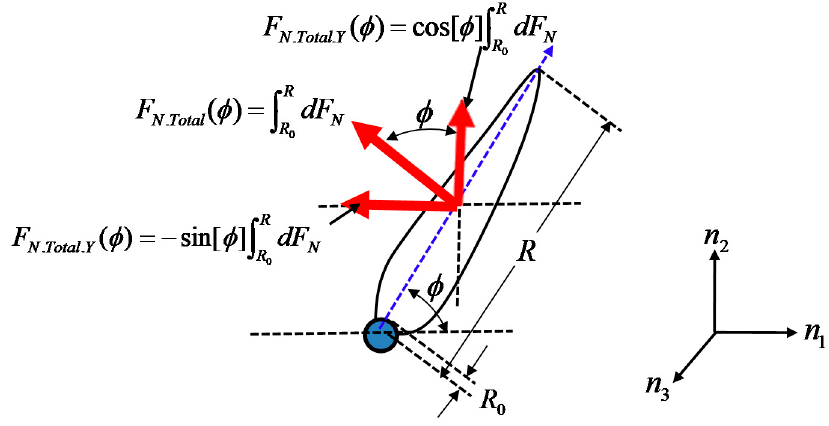
Figure 4. Total tangential forces generated by one blade.